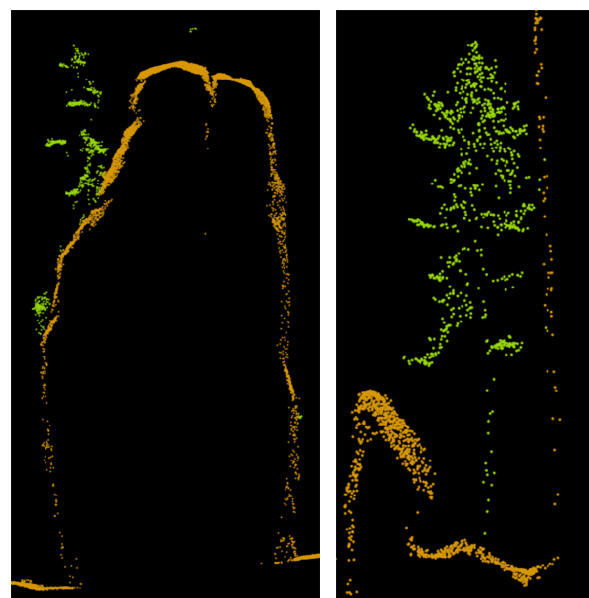
Figure 2. Profiles of manually filtered thinned data. Brown dots correspond to ground points and green dots to non-ground. In the images, Uhlířská rock pillar (Figure 1) with the tree growing